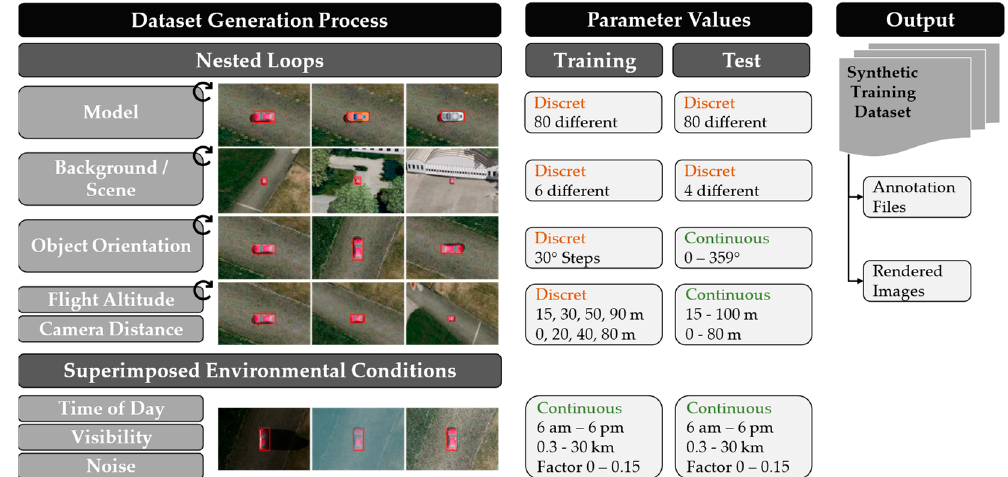
Figure 3. Schematic representation of the synthetic training data generation process. The e ff ects and the discrete or continuous gradations of the parameter values are shown. The result is a synthetic training dataset with rendered images and the respective annotation fi les.